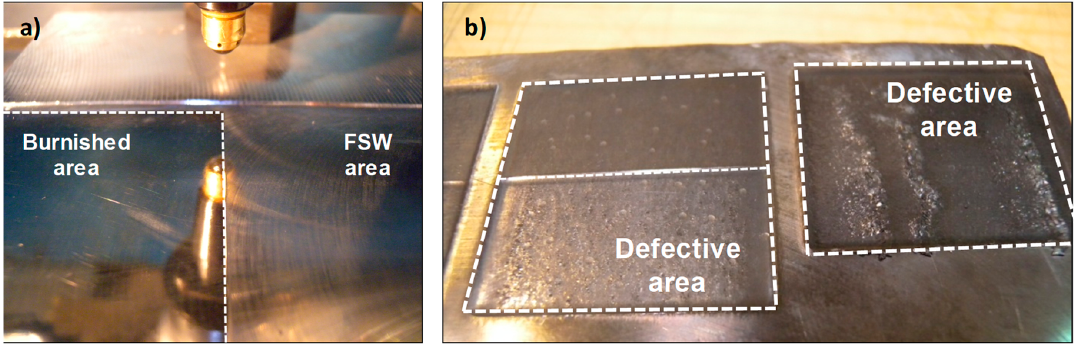
Figure 3. Burnished area details. ( a ) Correct burnished area; ( b ) excessively deformed area: visible defect.